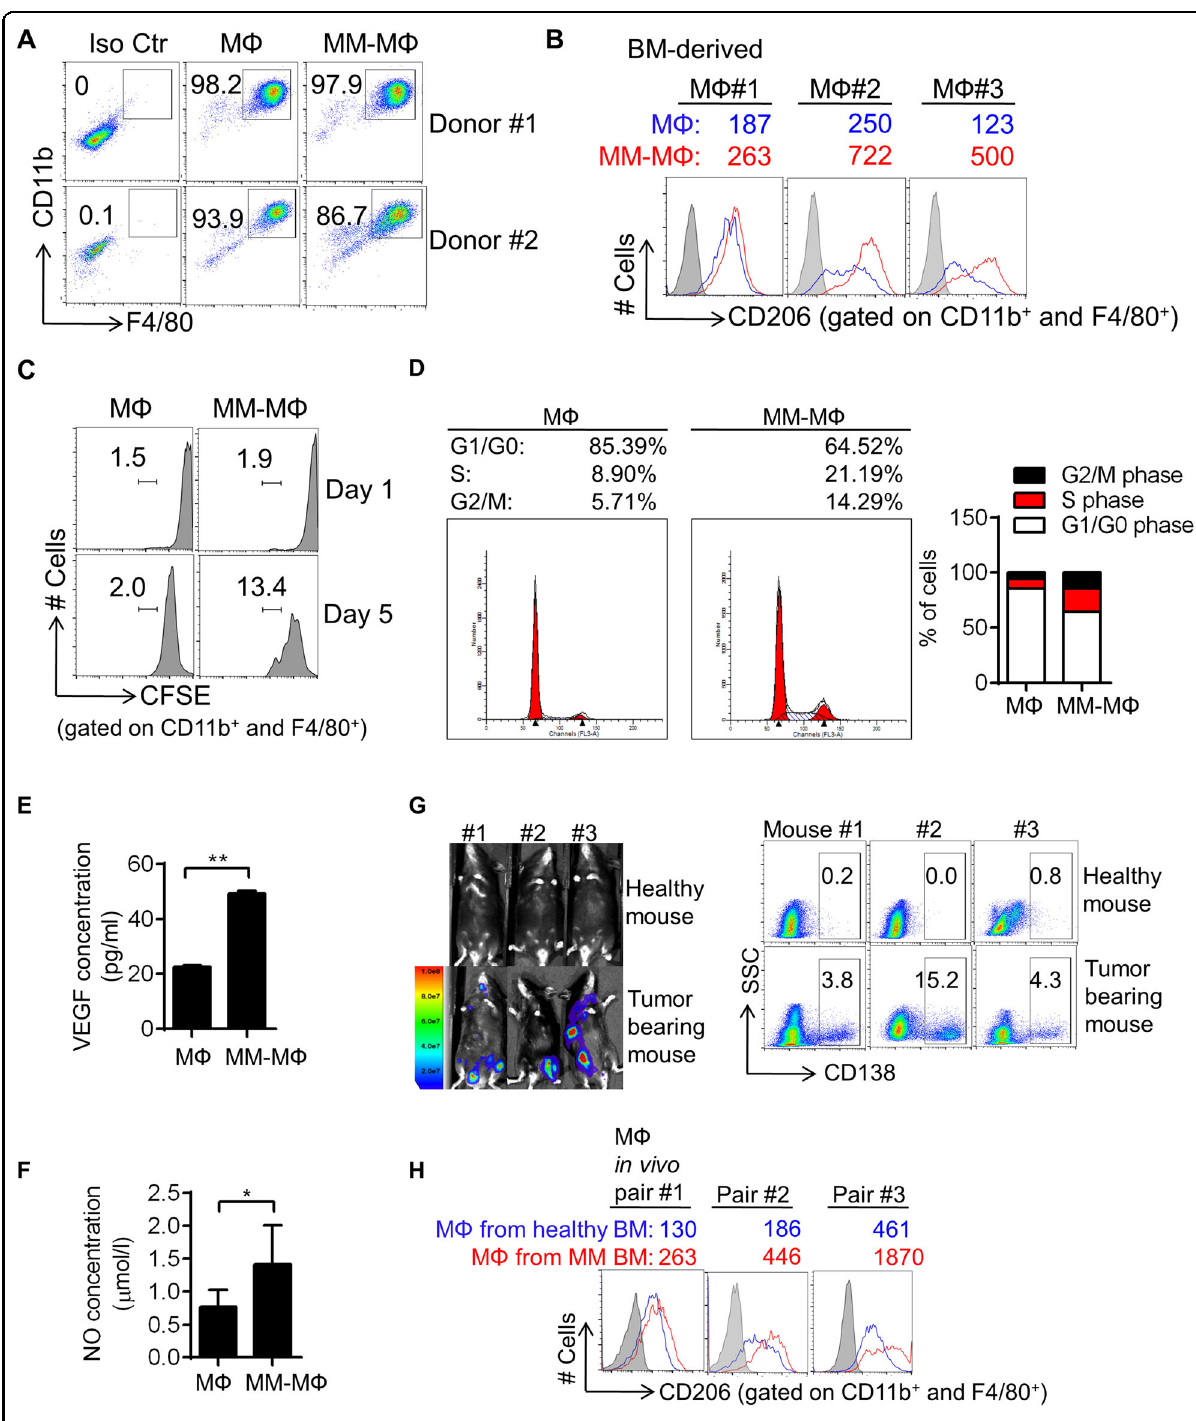
Fig. 1 Characterization of MM-M Φ s in a murine myeloma model. A Flow cytometry showed murine BM-derived M Φ s and MM-M Φ s were positive of F4/80 and CD11b staining. B Mean fl uorescent intensity (MFI) of fl ow cytometry indicated in vitro cultured MM-M Φ s expressed higher CD206 than M Φ s. C In CFSE proliferation assay, MM-M Φ s showed higher cell proliferation capacity than M Φ s. D Cell cycle analysis showed that MM- M Φ s had more S and G2/M population, relative to M Φ s. E ELISA assay detected the concentration of VEGF in culture supernatant of murine BM- derived M Ф s and MM-M Ф s. Statistical signi fi cance was determined by two-tailed Student t -test between M Ф s and MM-M Ф s, ** P < 0.01. F Culture supernatant of murine MM-M Ф s had higher nitric oxide concentration, relative to M Φ s. Statistical signi fi cance was determined by two-tailed Student t -test between M Ф s and MM-M Ф s, * P < 0.05. G 5 T murine myeloma model was used for identifying in vivo MM-M Φ features, IVIS photos (left) and CD138 staining (right panel) of BM cells illustrated myeloma tumor burden. Results from 3 representative mice from 7 injected mice are shown. H M Φ s from myeloma-bearing mice expressed higher CD206 than those from health